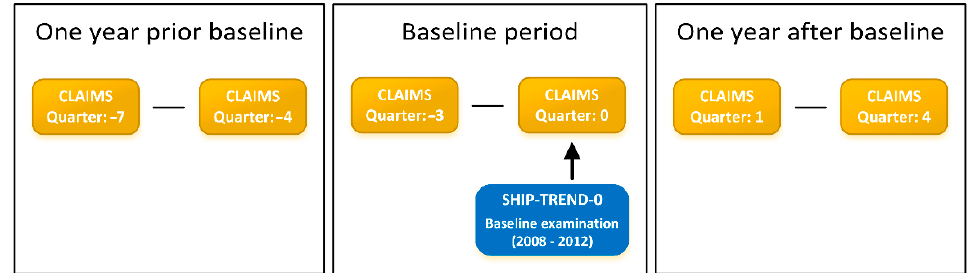
Figure 1. Study design overview.